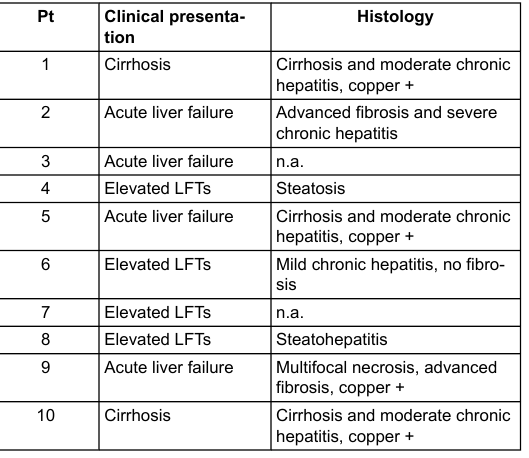
Table 3: Histological lesional patterns.